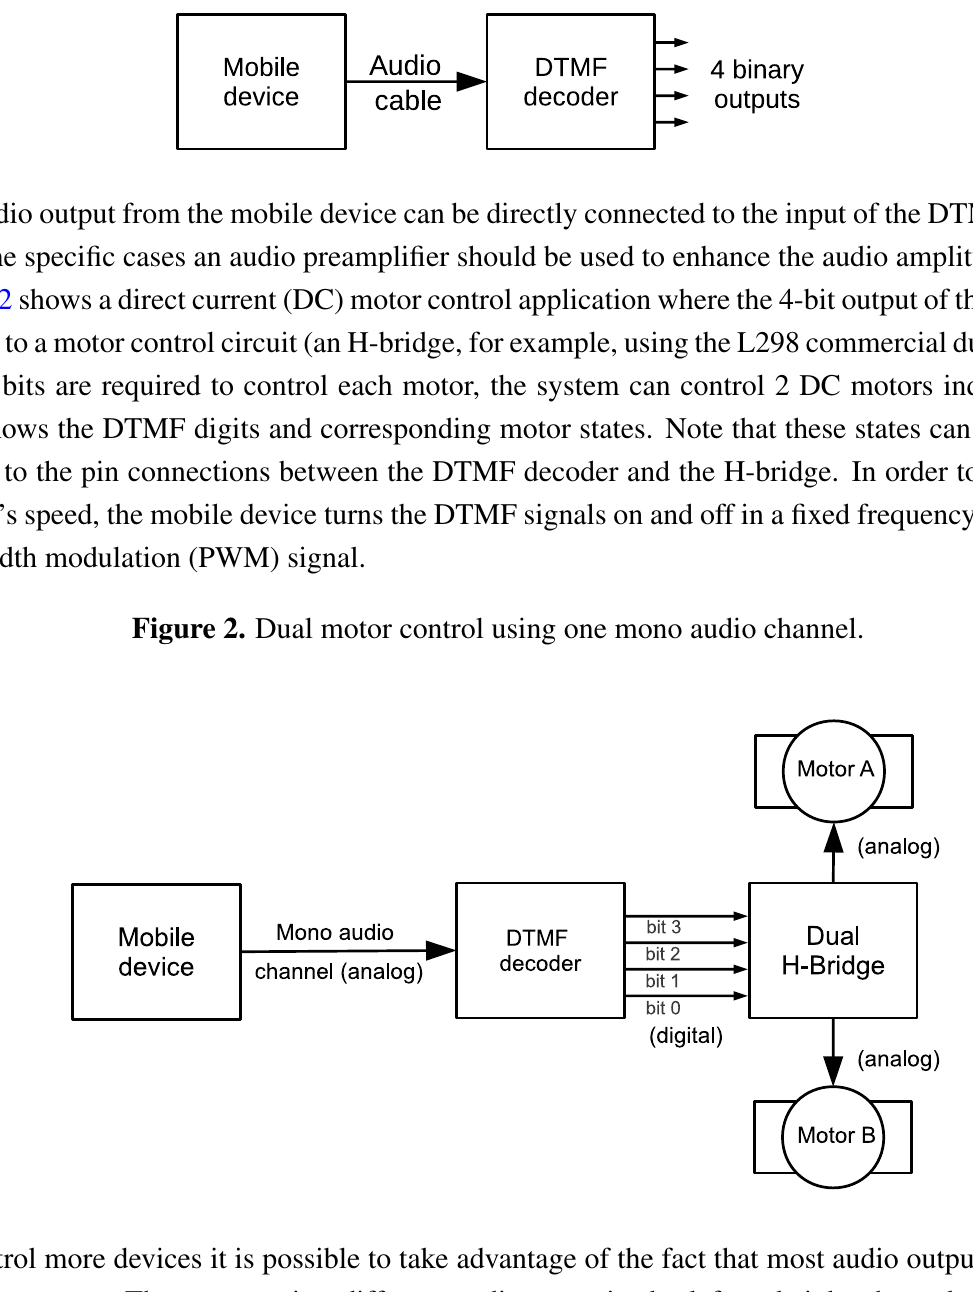
Figure 1. DTMF decoder with four independent outputs controlled by audio from a mobile device.